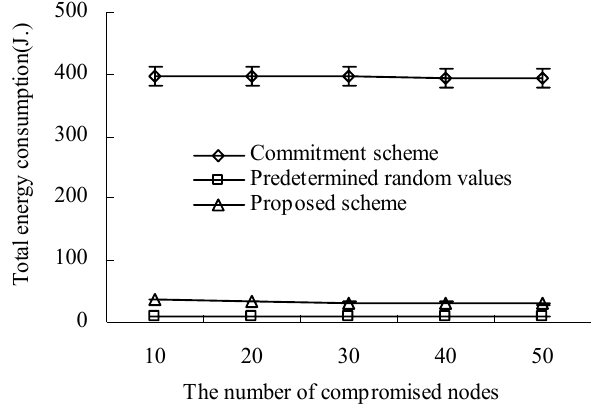
Figure 8. Total energy consumption vs. compromised